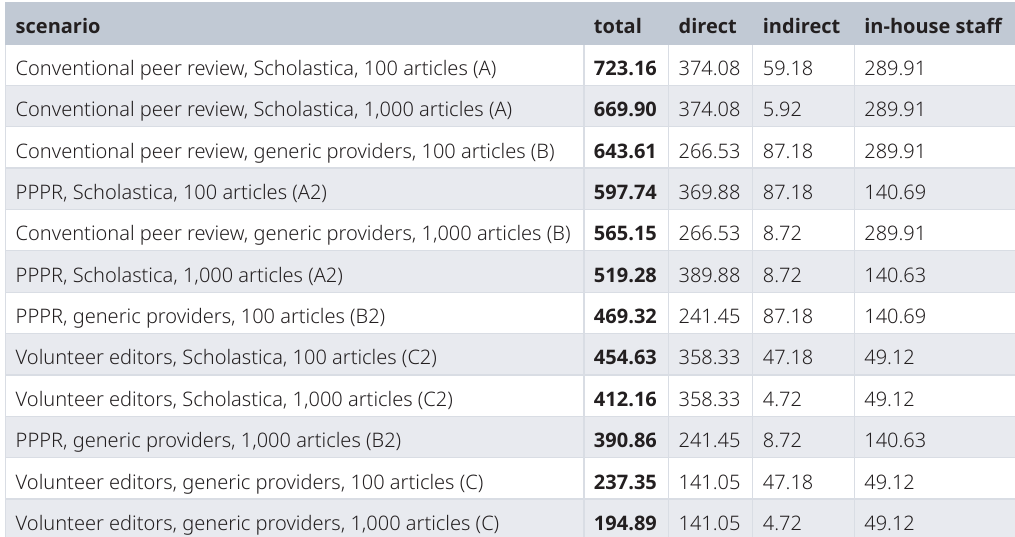
Table 4. Different scenarios of journal organization, ordered by total per article costs (in US$). The scenarios are labeled with A, A2, B, B2, C, C2 (see Table 3). Values correspond to an average 50% rejection rate, 90% rejection rate calculations in the